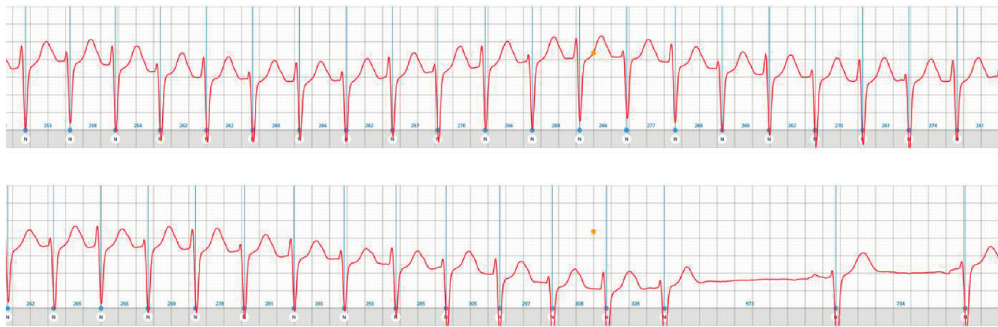
Figure 3: ECG recording from the patient during an episode of tachycardia